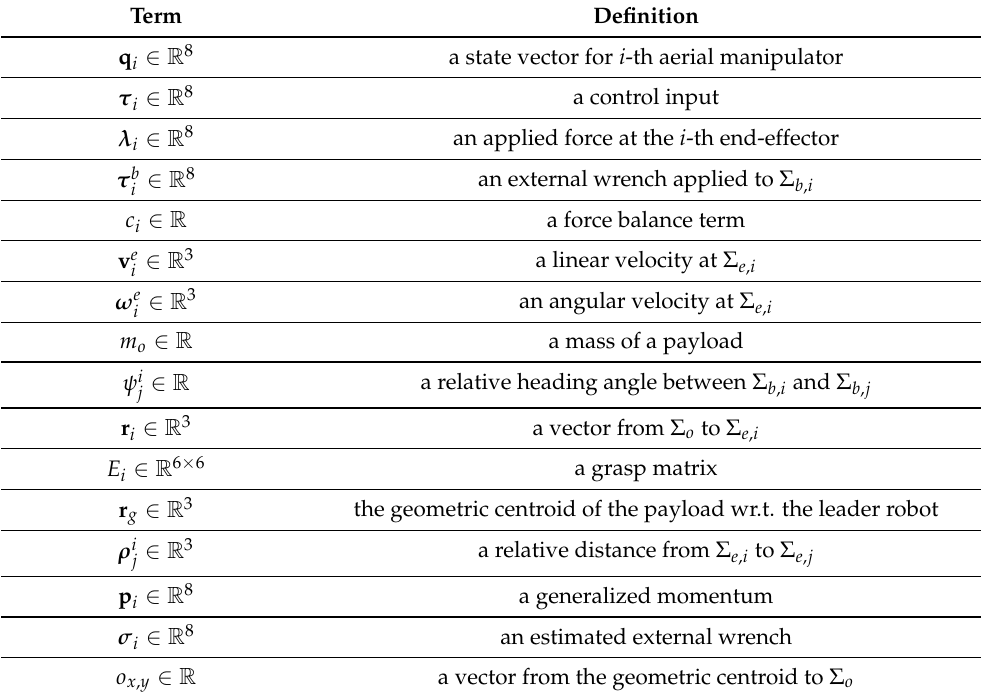
Table 1. The major terms used in this